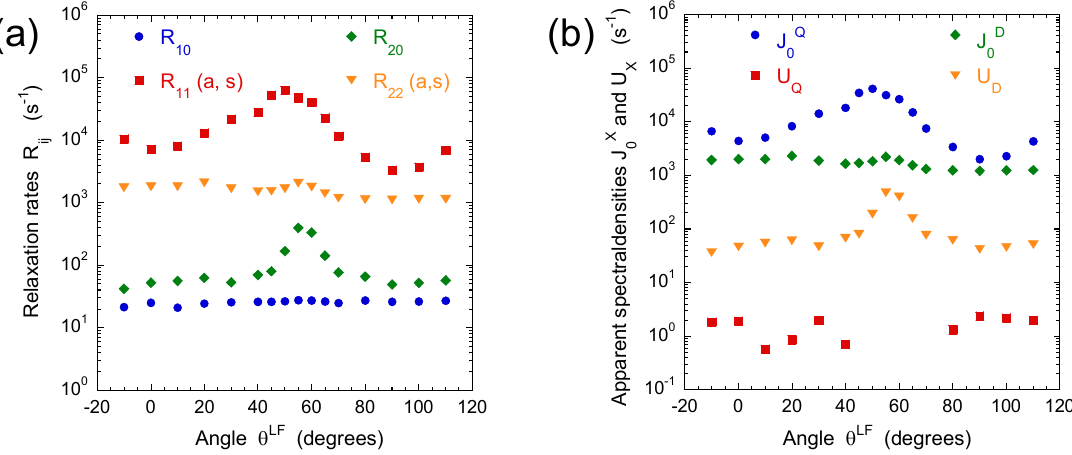
Figure 6. Variations as a function of the film orientation θ LF into the static magnetic field B 0 of: ( a ) the apparent multi-quantum relaxation rates of the T 10 , T 11 ( a , s ) , T 20 and T 22 ( a , s ) coherences, denoted R 10 , R 11 ( a , s ) , R 20 and R 22 ( a , s ) , respectively; and ( b ) the apparent spectral densities J Q ( 0 ) , U J D Q and U D extracted from these R ij values (see Equation (A24)). Reprinted with permission 0 from [52]. Copyright (2013) American Chemical